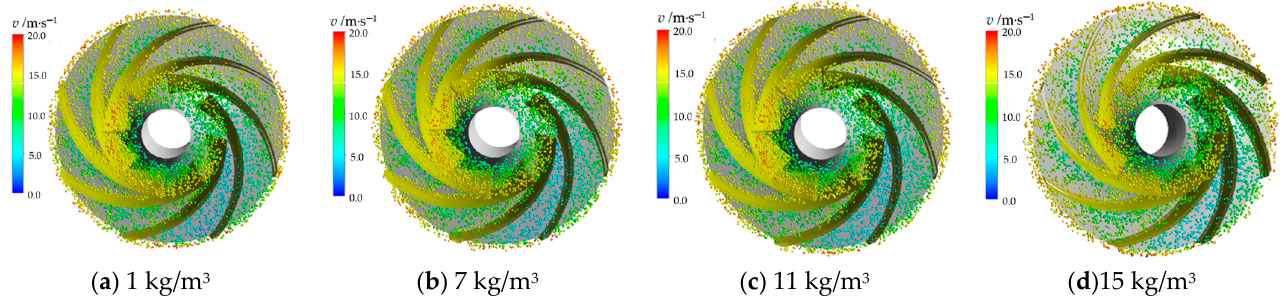
Figure 17. Particle distribution under different particle concentrations.